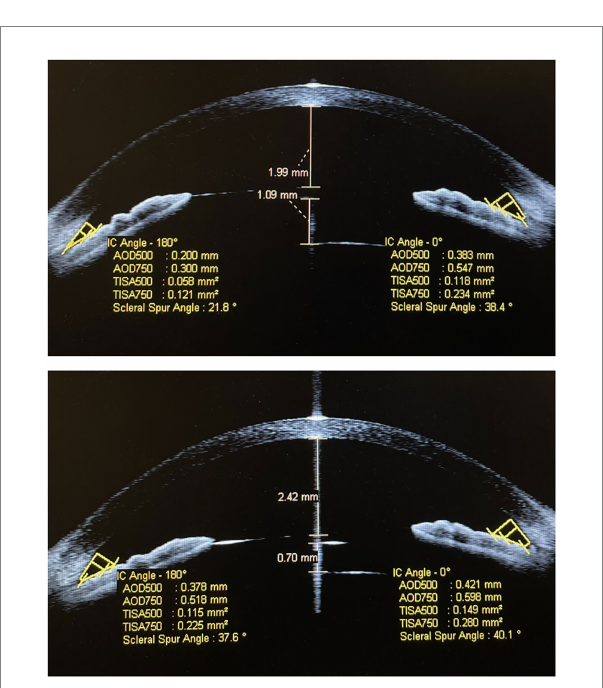
FIGURE 3 Anterior segment OCT image shows that the ICL vault was 1,090 μ m and the anterior chamber depth was 1,990 μ m before rotation (A) in patient B; 1 week after the rotation, the ICL vault was 700 μ m and the anterior chamber depth was 2,420 μ m (B)